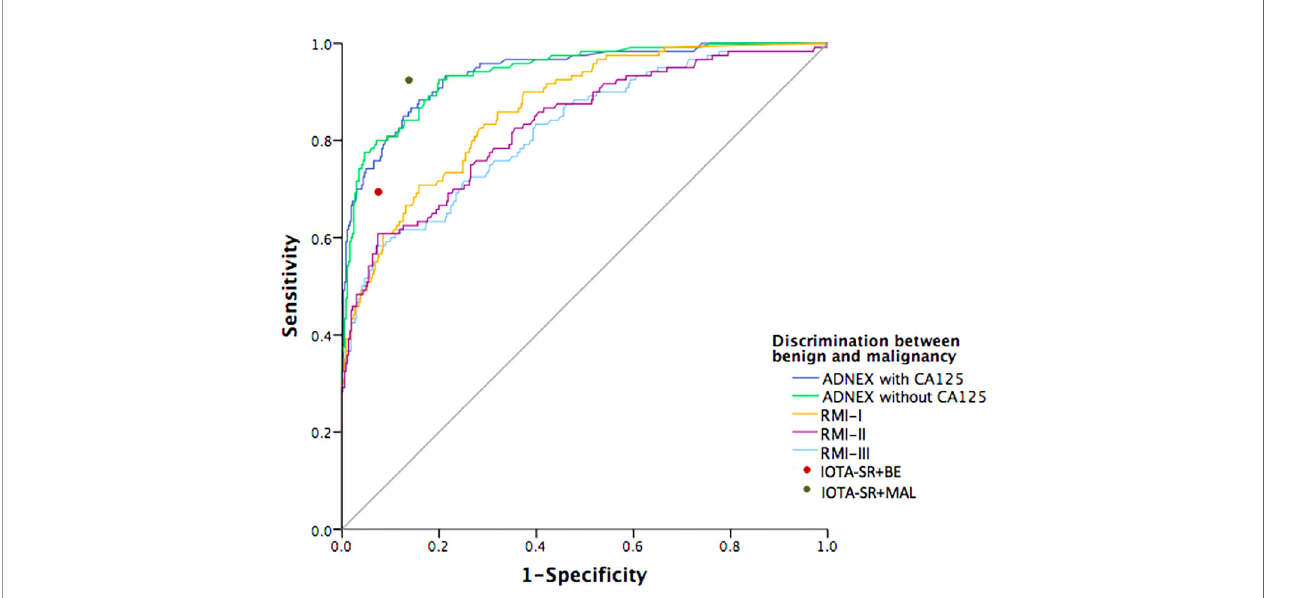
FIGURE 2 | Receiver-operating characteristic curves for the performance of prediction models in detection of malignant adnexal masses. The prediction models including: Assessment of Different NEoplasias in the adneXa (ADNEX) model and three variants of the Risk of Malignancy Index (RMI). The red and green ROC point represents the Simple Rules model applied with inconclusive diagnoses classi fi ed as either benign (red) or malignant (green).